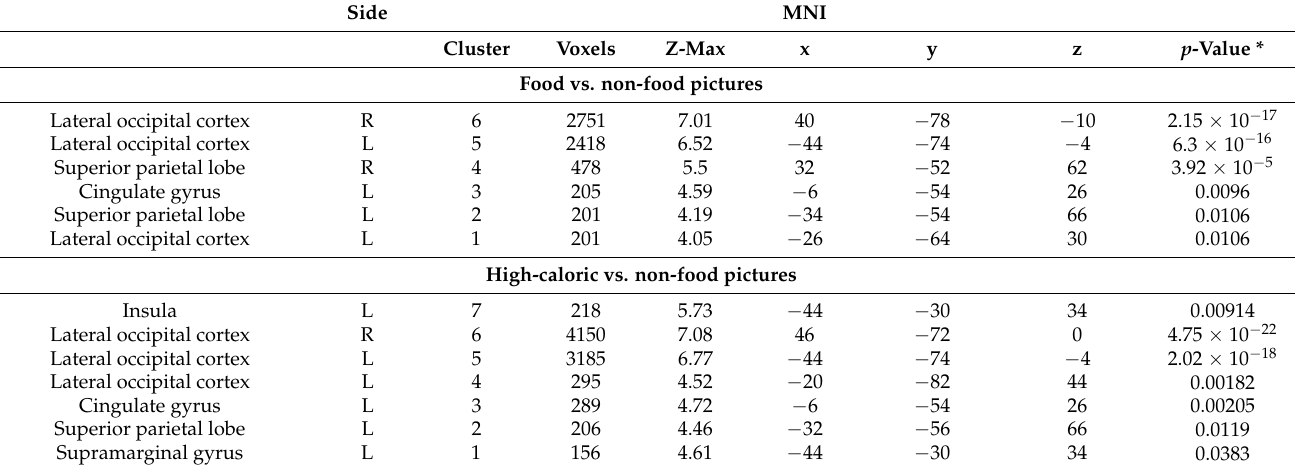
Table 4. Significant results of the main effects observed in the fMRI virtual food task of whole-brain analyses. Side MNI Cluster Voxels Z-Max